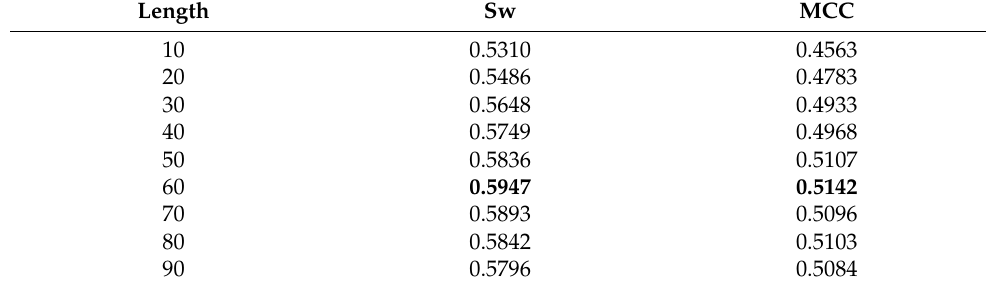
Table 6. Prediction performance of different window lengths in BP network.